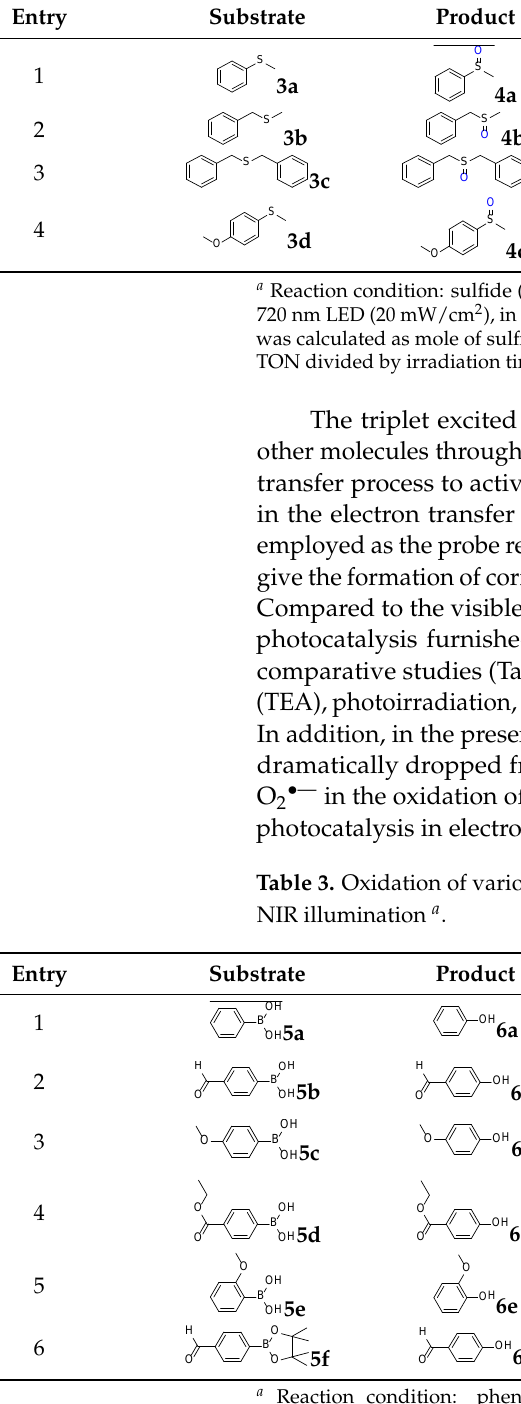
Table 2. Oxidation of various sulfides using BDP as the photocatalyst under NIR illumination a .